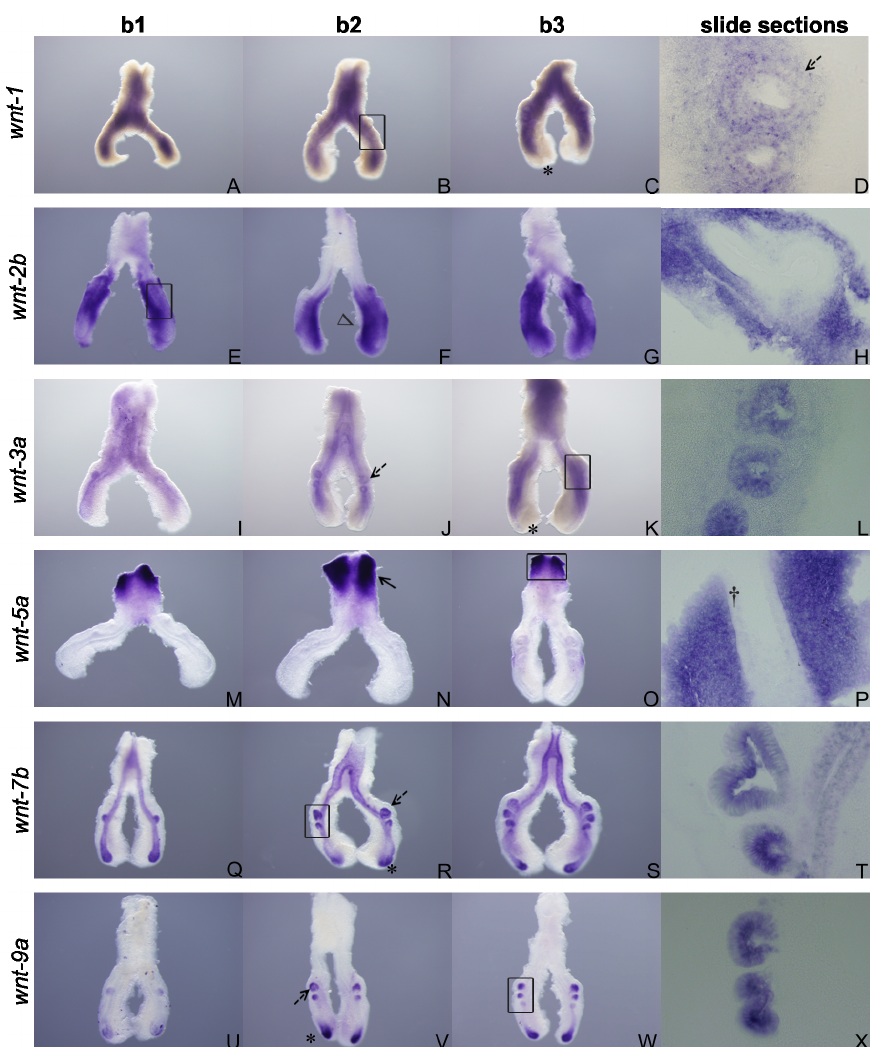
Figure 1. Wnt ligands expression pattern in early stages of chick lung development. Representative examples of in situ hybridization of wnt-1 (A–D), wnt-2b (E–H), wnt-3a (I–L), wnt-5a (M–P), wnt-7b (Q–T), wnt- 9a (U–X) of stage b1, b2 and b3; n 5 15 per stage. Open arrowhead – medial mesenchyme. Black arrow – proximal mesenchyme. Dagger – proximal epithelium. Asterisk – epithelial tip of the main bronchus. Dashed black arrow – secondary buds epithelium. Magnification: whole mount, 5 6 ; slide sections, 20 6 . The black rectangle in images B, E, K, O, R and W indicate the region shown in corresponding slide section.